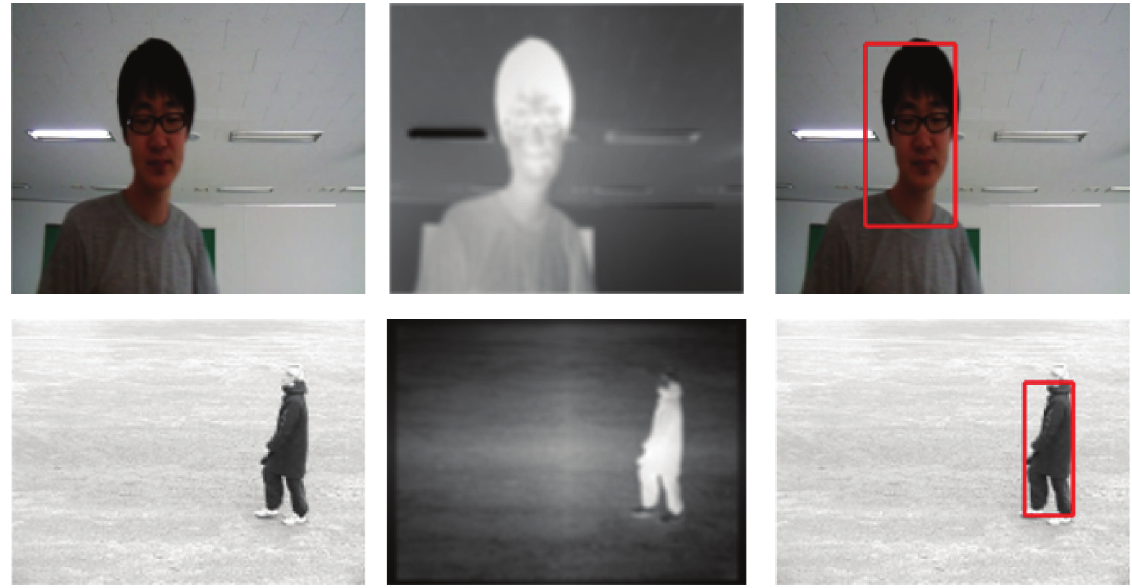
Figure 7: Videos (7) and (8): results using modified frequency tuned spatial model